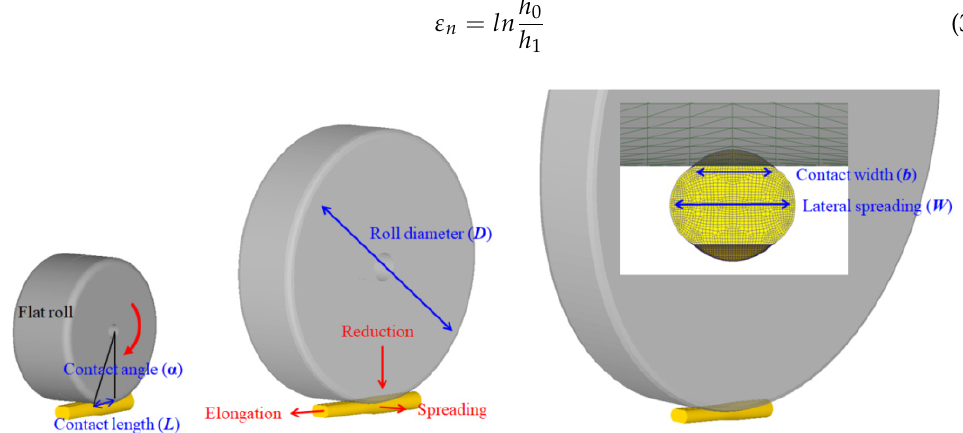
Figure 1. Schematic illustration of wire flat rolling with the roll diameter and related parameters used in this study.